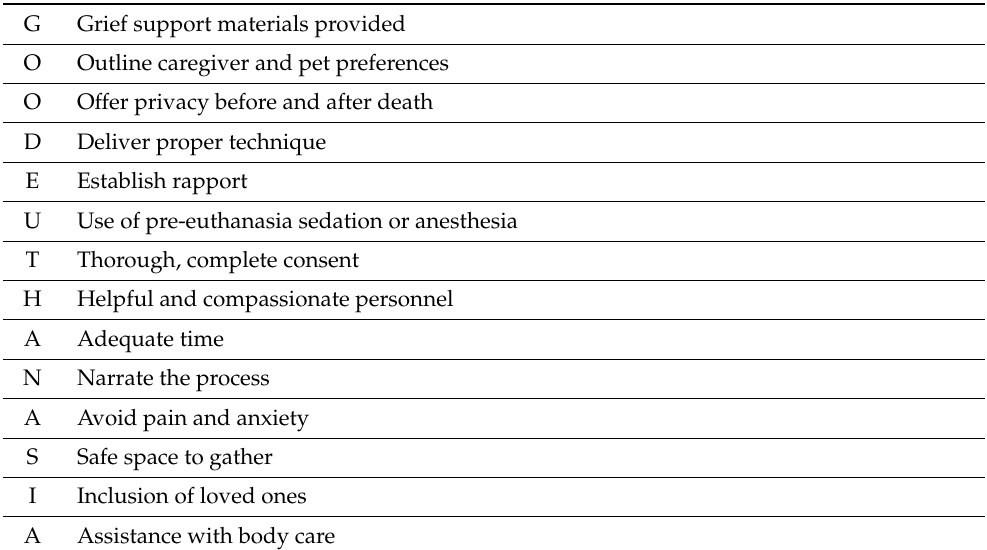
Table 1. The 14 essential components of a companion animal euthanasia (CAETA)